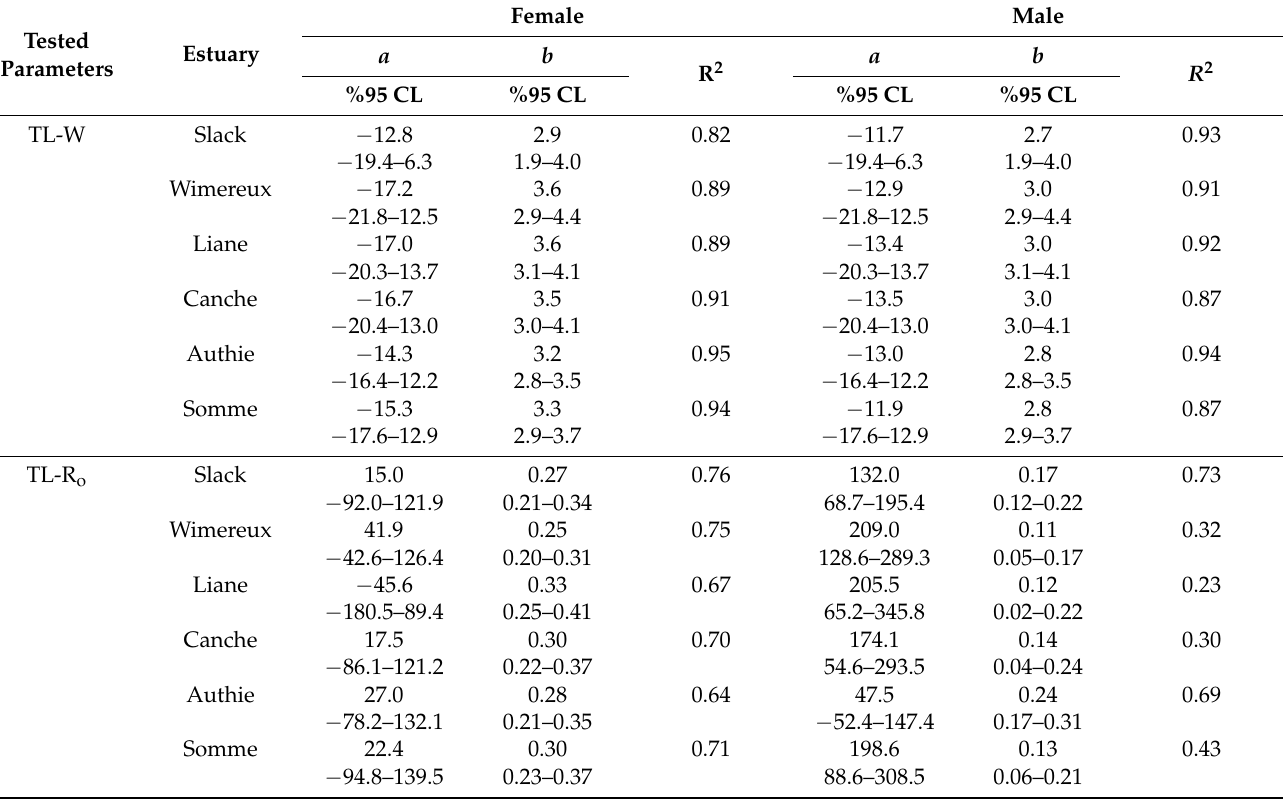
Table 1. Length–weight (TL-W) and length–otolith radius (TL-R o ) relationship parameters for female and male eels collected in six estuaries. The values of coefficient a , the intercept or initial growth coefficient and b , the slope i.e., the growth coefficient and 95% confidence limits (%95 CL). R 2 is the correlation